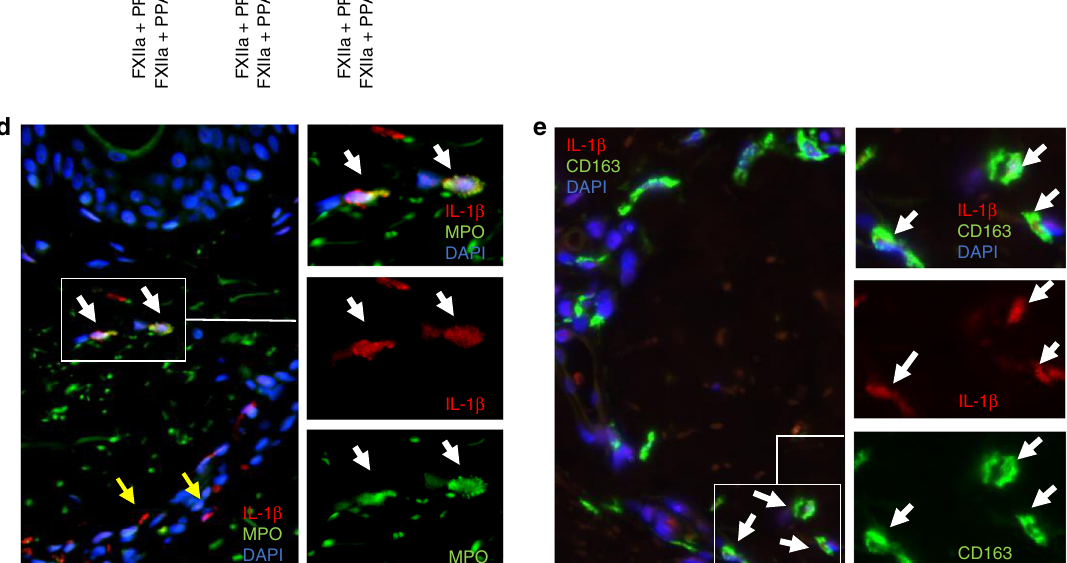
Fig. 5 FXII W268R induces and increases IL-1 β secretion and expression. a – c Peripheral blood mononuclear cells were isolated from healthy control subjects by density-gradient centrifugation. Interleukin-1 β (IL-1 β ) secretion requires a two-step process: (i) transcriptional upregulation of pro-IL-1 β via toll- like receptors and (ii) conversion of pro-IL-1 β into its active form by in fl ammasome activation. Cells were pre-stimulated with toll-like receptor agonist lipopolysaccharide (LPS), and nucleotide binding like receptor protein 3 (NLRP3) in fl ammasome activation was induced by the danger molecule ATP (LPS + ATP = blue symbols). Red symbols denote LPS-stimulated cells only, and green symbols represent ATP-activated cells without priming by LPS. Experiments were performed in the presence of FXII-depleted plasma (control) and addition of recombinant FXII wild-type (rFXII wt) and W268R (rFXII W268R) protein ( a ) or rFXII W268R-S544A ( b ). Experiments in ( c ) were conducted with puri fi ed FXII, FXIIa, and different doses of the small peptide- based inhibitor PPACK. Black arrows indicate priming effect by the mutant rFXII W268R ( a ) and the active site incapacitated rFXII W268R-S544A ( b ), which was absent in rFXII wt and control. Also, the presence of FXIIa (with or without PPACK) did not induce changes in IL-1 β release ( c ). IL-1 β secretion was assessed by ELISA. Pooled data of n = 3 different ( a ) or n = 2 ( b , c ) experiments. Bar graphs show individual data points and the mean ± s.e.m. Statistical signi fi cance in is indicated by one-way ANOVA ( a , c ) with Tukey ’ s multiple comparisons test for ATP between the groups control vs. rFXII W268R and rFXII wt vs. rFXII W268R ( a ) or unpaired Student ’ s t test ( b ). d, e Representative image from serial sections of the lesional skin from FACAS patient following cold exposure exhibits IL-1 β immunoreactivity. IL-1 β expression is pronounced around blood vessels (yellow arrows) and co-localizes with neutrophils ( d ) and macrophages ( e ) (white arrows). Original magni fi cation ×400, n = 2 technical replicates. Source data are provided as a source data fi